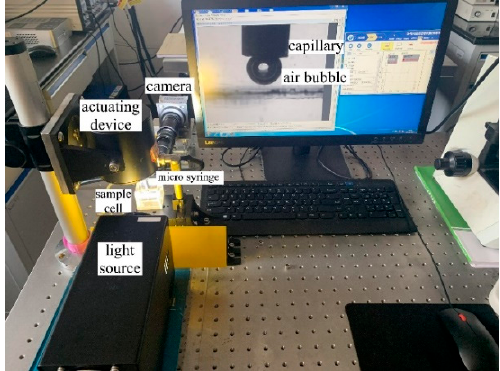
Figure 1. The induction time measurement device.